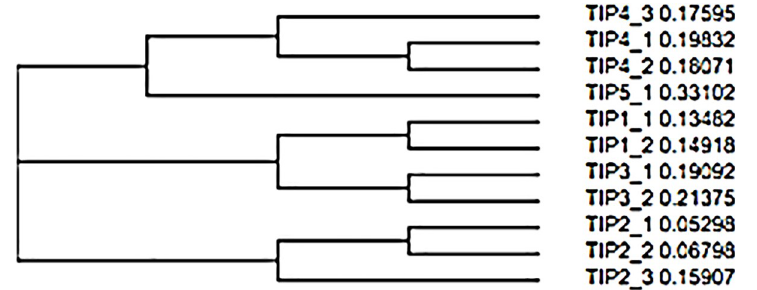
Fig 2. Tree of genetic similarity of barley aquaporins form TIP subfamily based on amino acid sequences of HvTIPs using Clustal Omega software with the Neighbour-Joining Clustering